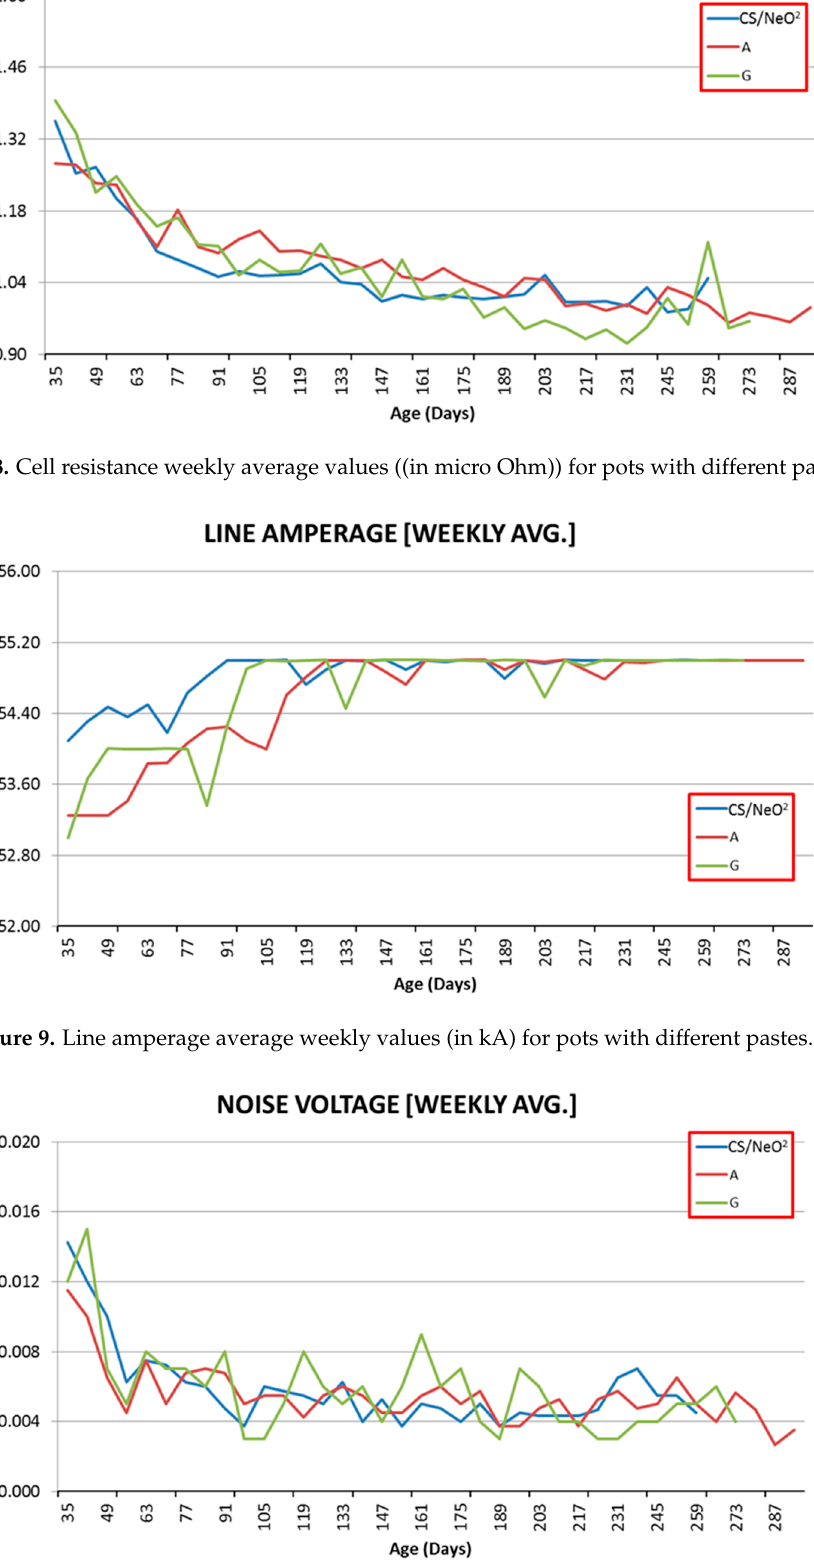
Figure 11. Cathode resistance average weekly values (in micro Ohm) for pots with different pastes. 5.2. Pot Age Distribution